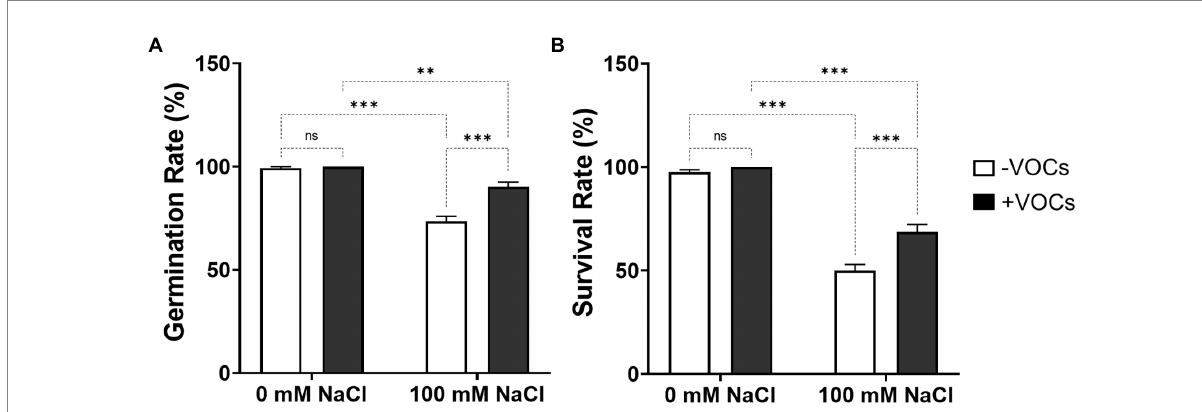
FIGURE 2 Effects of volatile organic compounds (VOCs) of B. pyrrocinia CNUC9 on Arabidopsis seed germination and survival rates under non-stress and salt stress conditions. (A) Germination rates and (B) survival rates were measured after 10 days. Error bars represent standard error of the mean (SEM) of three independent biological replicates ( n = 200 seedlings per replicate). Asterisks on bars of the same parameter indicate statistical differences among treatments according to two-way analysis of variance (ANOVA), followed by Tukey’s multiple comparison test ( ** p ≤ 0.01; *** p ≤ 0.001; n = 600). ns, non significant.